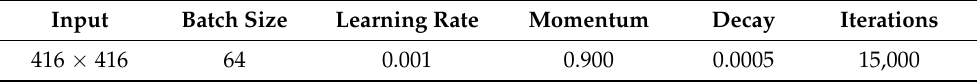
Table 2. Network parameters of YOLOv4.